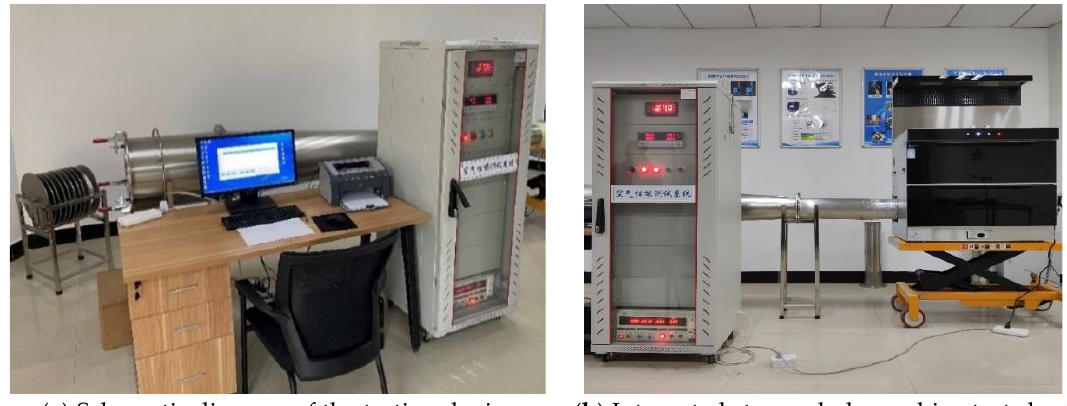
Figure 21. Air performance testing device.